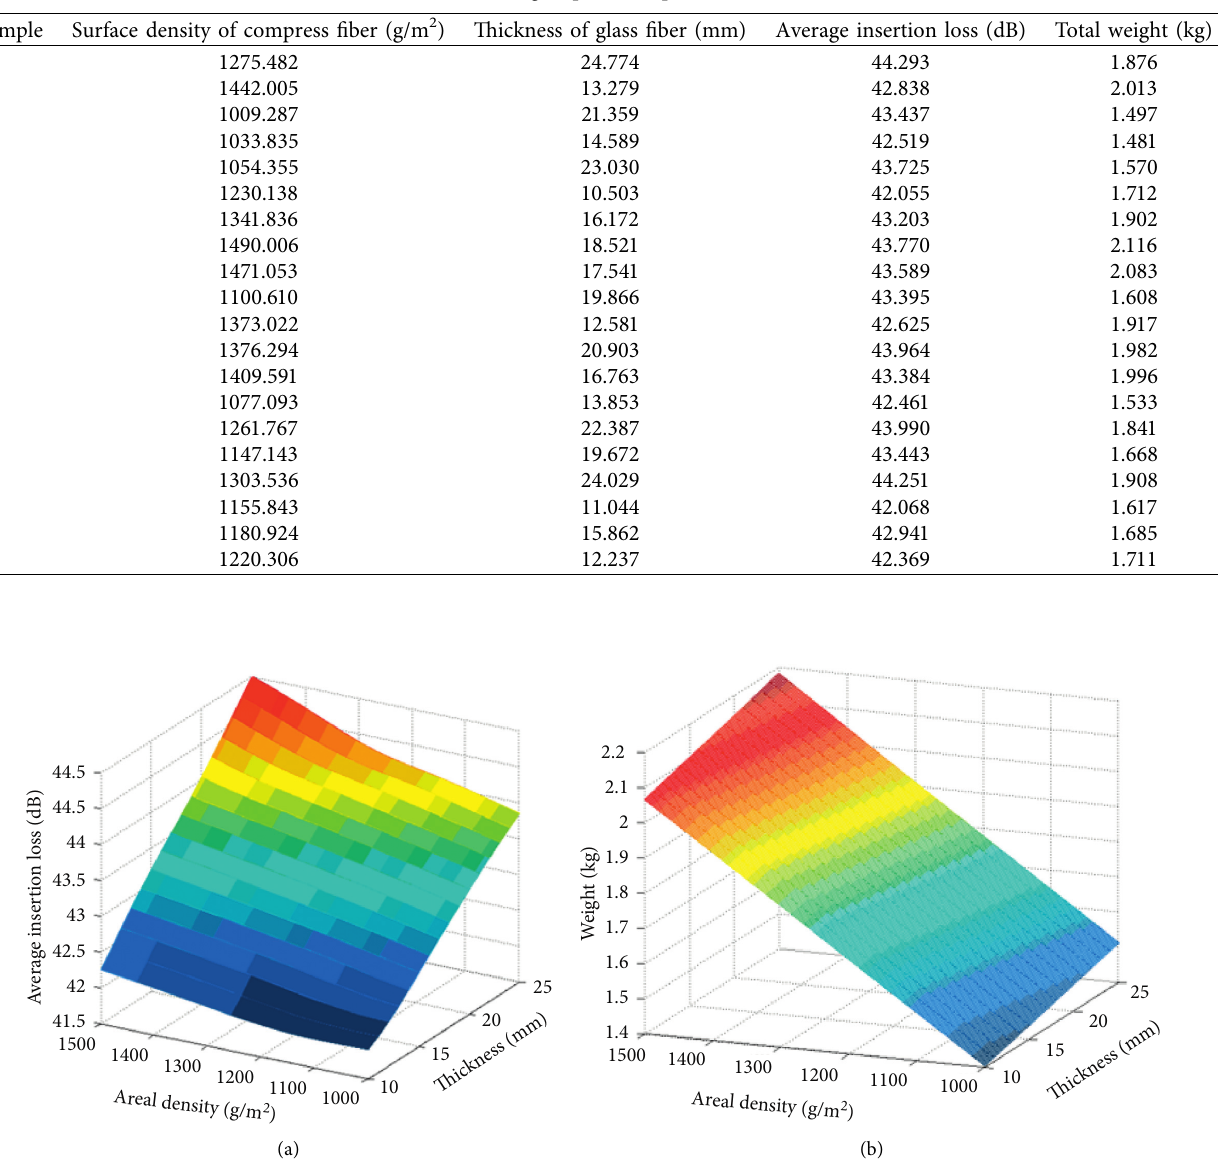
Table 8: 20 groups of samples of LHS.